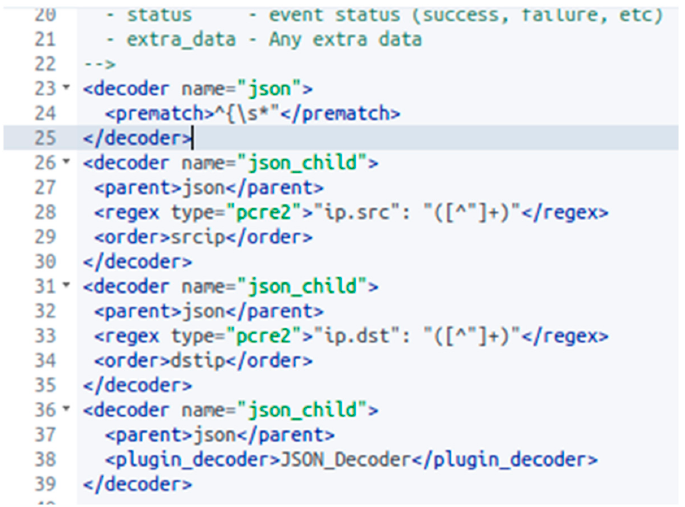
Figure 11 . Decoder for Custom Logs.